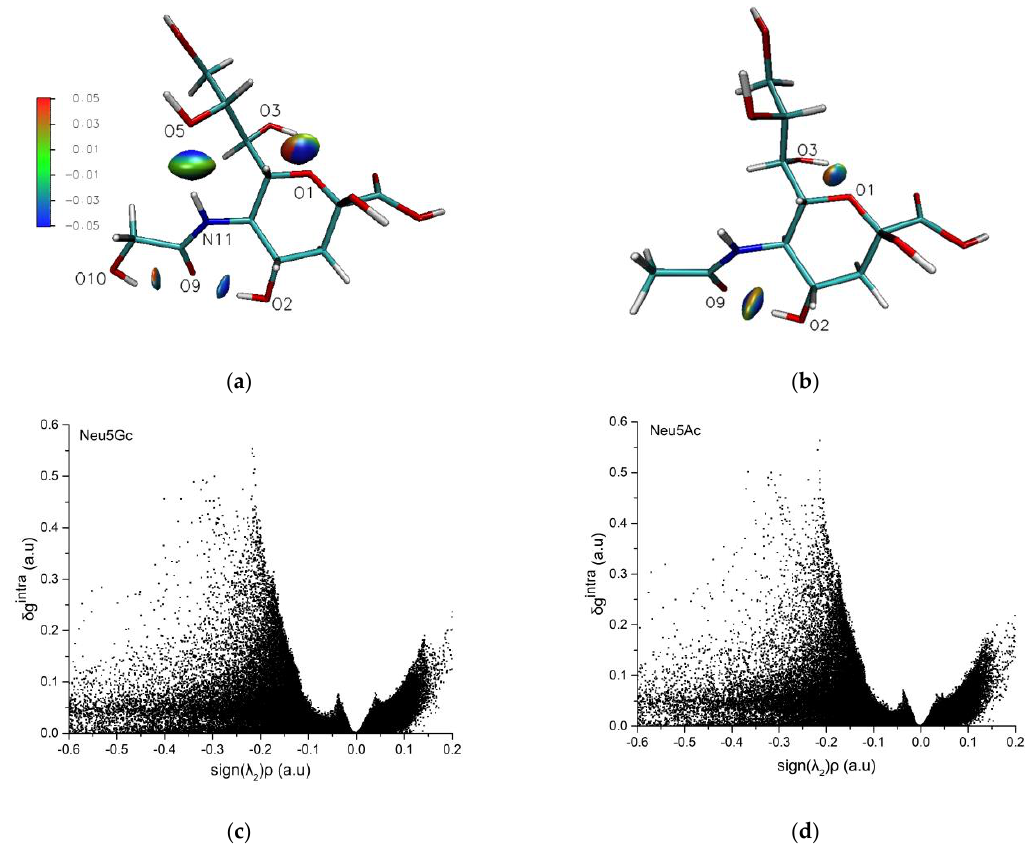
Figure 3. The independent gradient model (IGM) iso-surface and scatter plot of Neu5Gc and Neu5Ac. Note: ( a ) The iso-surface of Neu5Gc intramolecular non-covalent interaction; ( b ) The iso-surface of Neu5Ac intramolecular non-covalent interaction; ( c ) The scatter plot of Neu5Gc intramolecular non-covalent interaction; ( d ) The scatter plot of Neu5Ac intramolecular non-covalent interaction.